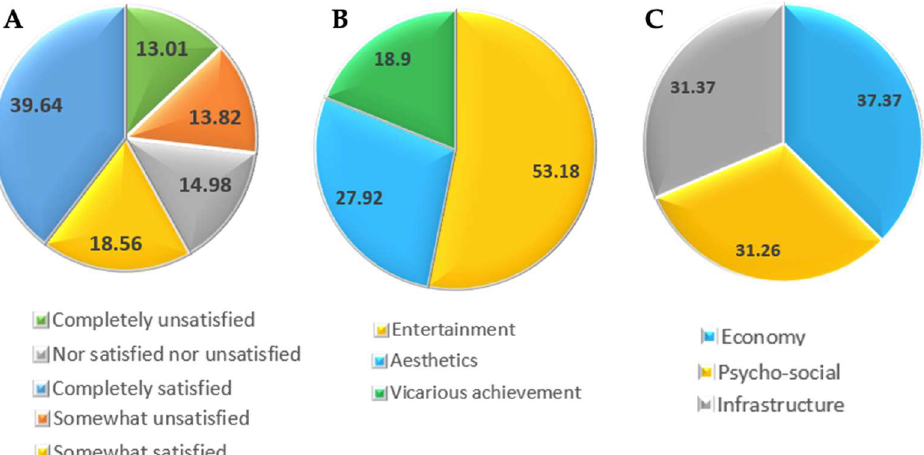
Figure 1. Community satisfaction in the implementation of PON XX ( A ), motivation to watch PON XX ( B ) and perception of the impact of PON XX in Papua ( C ).